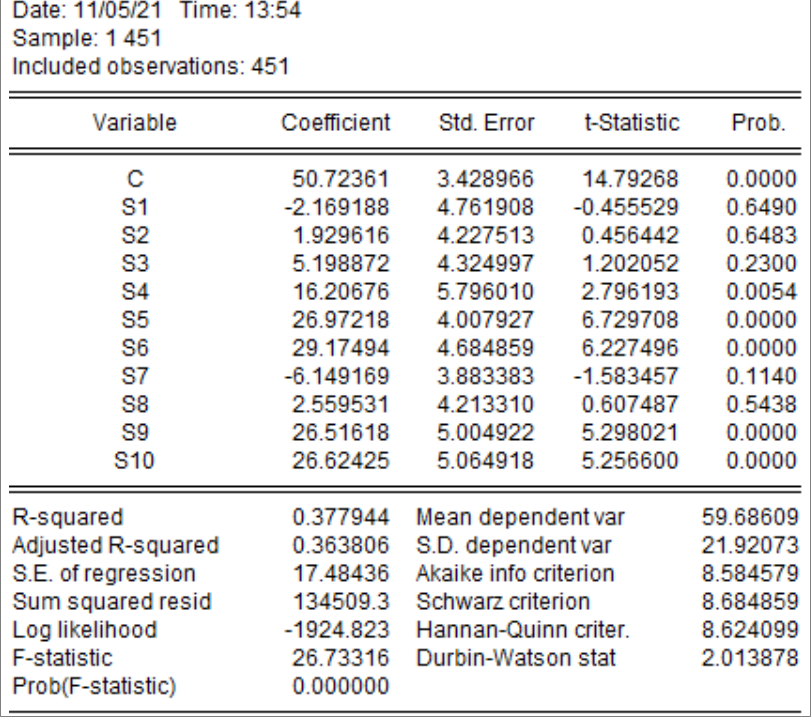
Figure 3. OLS regression estimation dummy variables for sectors (EViews data)